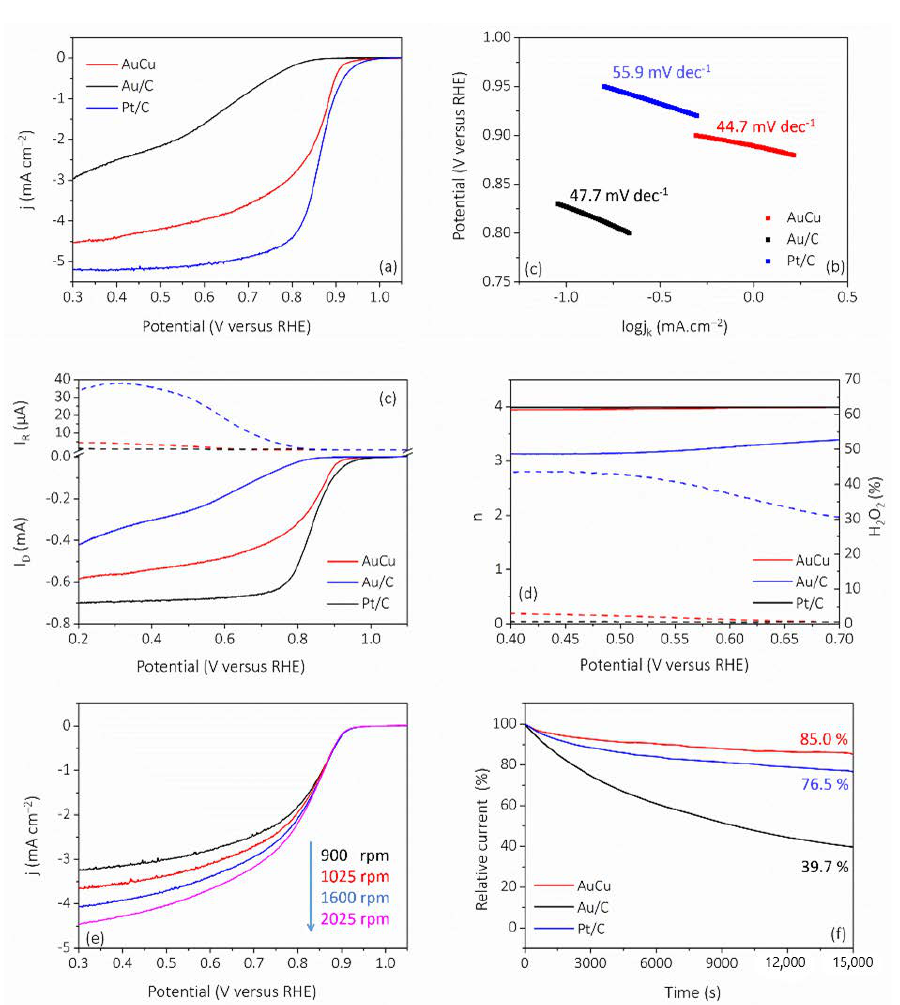
Figure 7. ORR electrocatalytic evaluation of AuCu. ( a ) LSV curves and ( b ) Tafel plots. ( c ) RRDE measurement at 1600 rpm and ( d ) corresponding n and H 2 O 2 % of AuCu, Au/C, and Pt/C. ( e ) LSVs of AuCu taken at various rpm. ( f ) CA curves of AuCu, Au/C, and